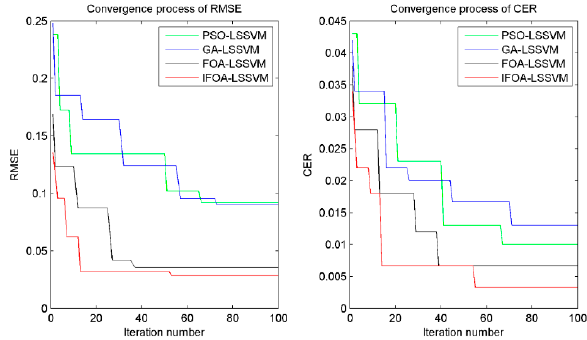
Figure 11. Comparison of PSO, GA, FOA and IFOA for optimization process.